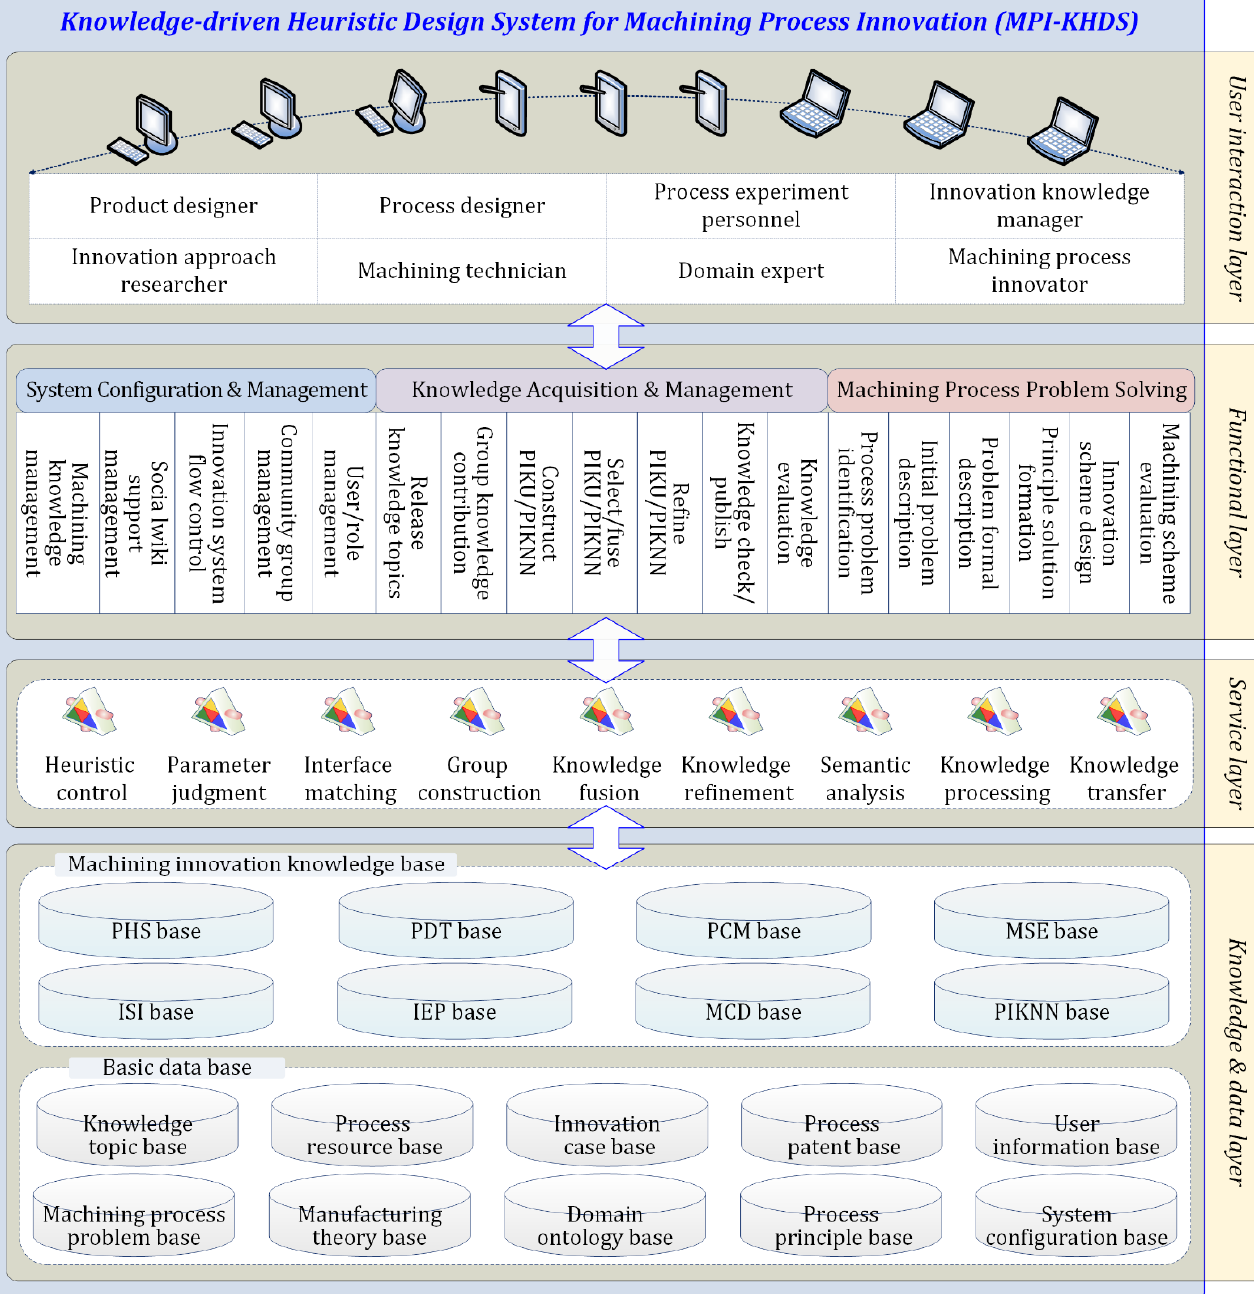
Figure 6. The system framework of MPI-KHDS.